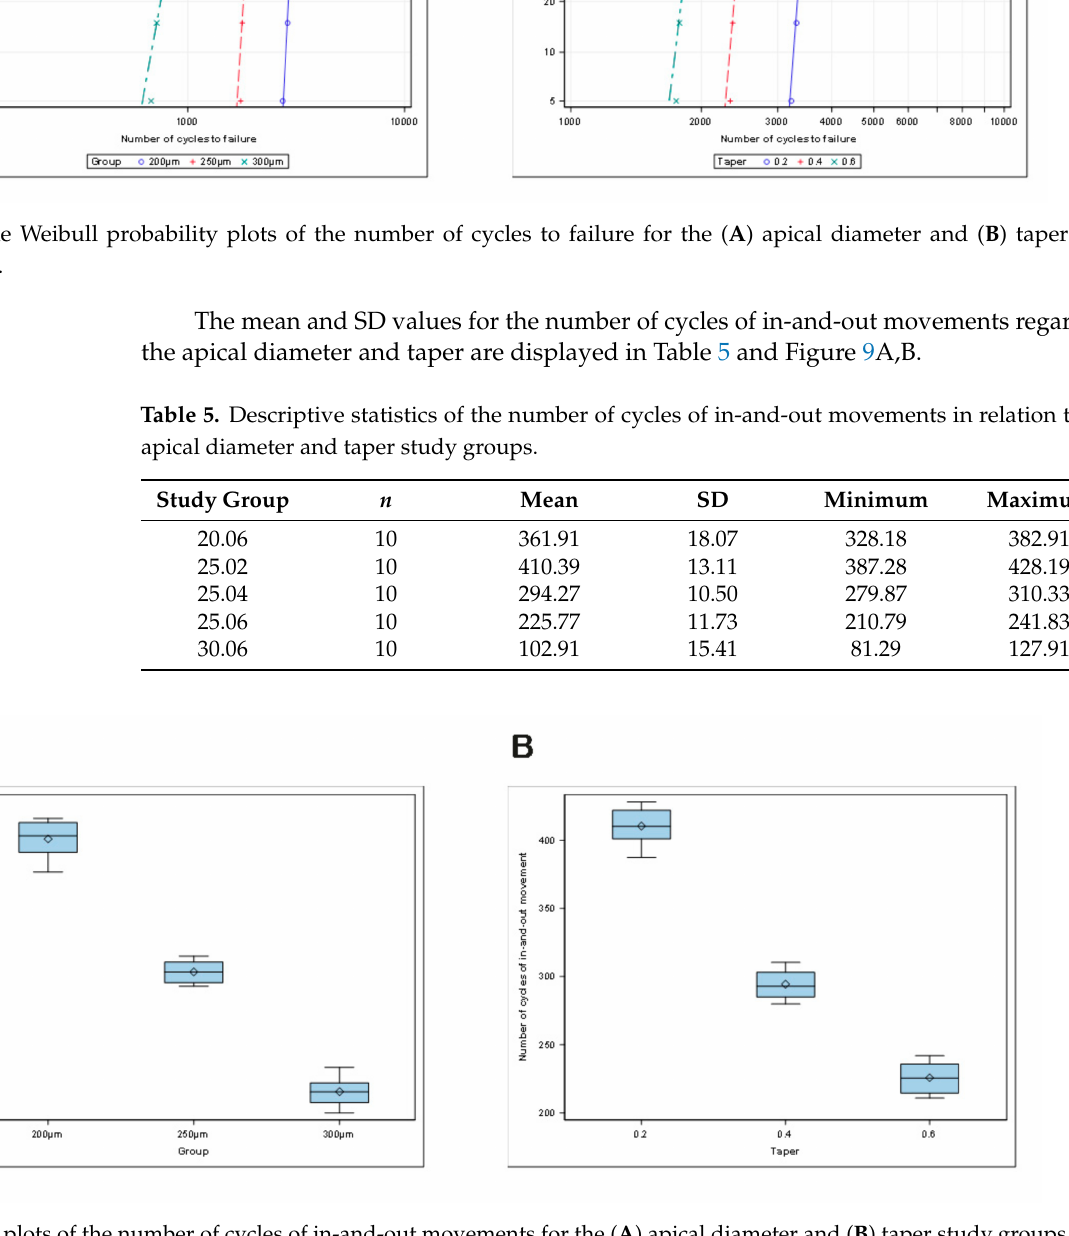
Figure 9. Box plots of the number of cycles of in-and-out movements for the ( A ) apical diameter and ( B ) taper study groups. The horizontal line in each box represents the respective median